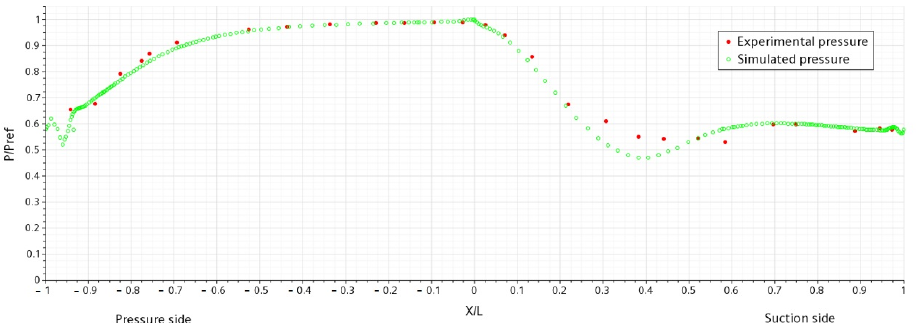
Figure 5. Comparison of the normalised static pressure from the experimental report and the numerical simulations at mid-span. The reference pressure is 413,286 Pa, as reported in